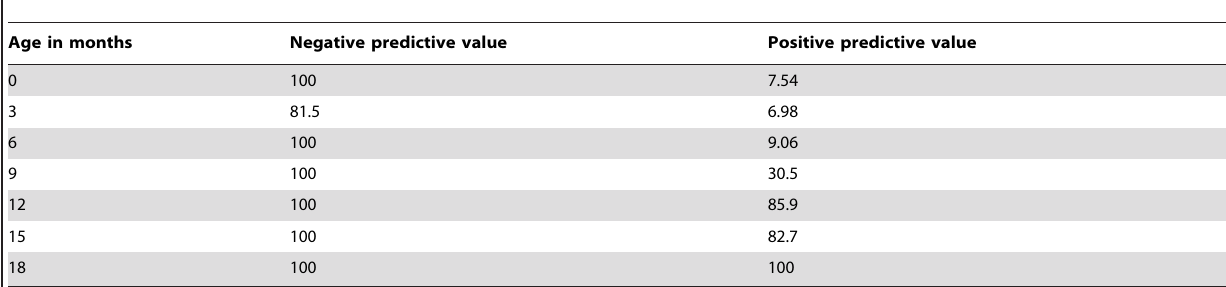
Table 2. Negative and positive predictive values with antibody ELISA